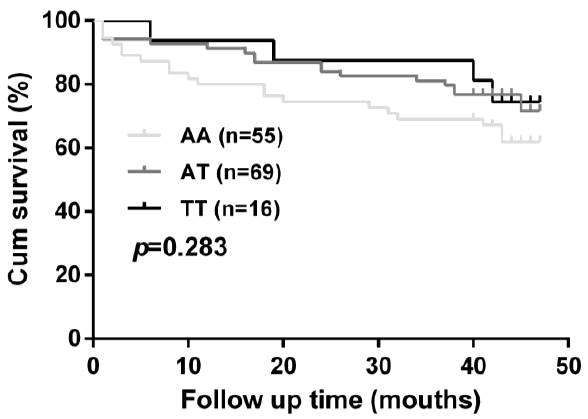
Figure 2. Effect of BSG rs8259 polymorphism on cardiovascular mortality in heart failure patients.